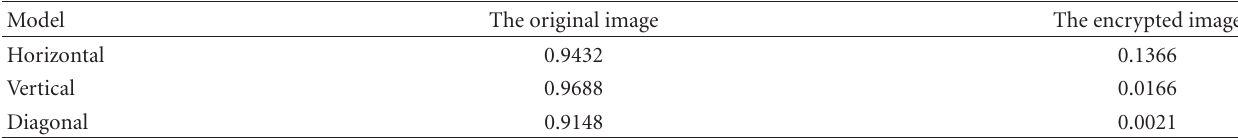
Table 1: Correlation coe ffi cients of two adjacent pixels in two image.